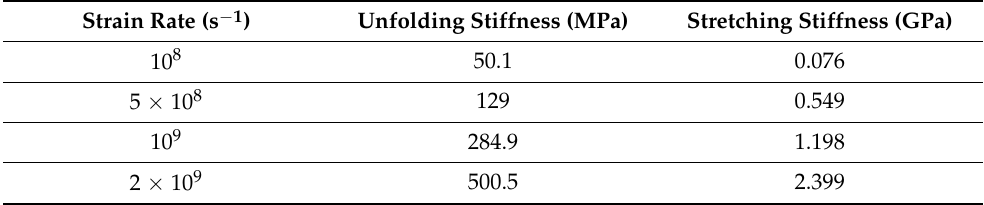
Figure 2. ( a ) Simplified schematic for tau protein unfolding and stretching ( ε xx = tensile strain). Initially, there are multiple folding (which are distinct from each other). When loading is applied, the van der Waals force and electrostatic force between the folded portions are broken, and therefore the structure unfolds. At extreme strain, the structure becomes free of all the folds, and stretches to a relatively linear filament. ( b ) Initial single tau structure (strain = 0%), ( c ) tau protein being unfolded due to pulling at 10 9 s − 1 (strain = 36%), ( d ) tau protein being stretched (strain = 206%, only the projection domain is shown for the convenience of visualization). Color legends: green: projection domain, red: MT binding region, blue: N terminus or tail, white, and the rest: inter-repeats between the MT binding regions. The enlarged snapshots are for the first ~1100 atoms for convenient visualization. Water molecules are not shown. Table 1. Unfolding stiffness and stretching stiffness of the projection domain of single